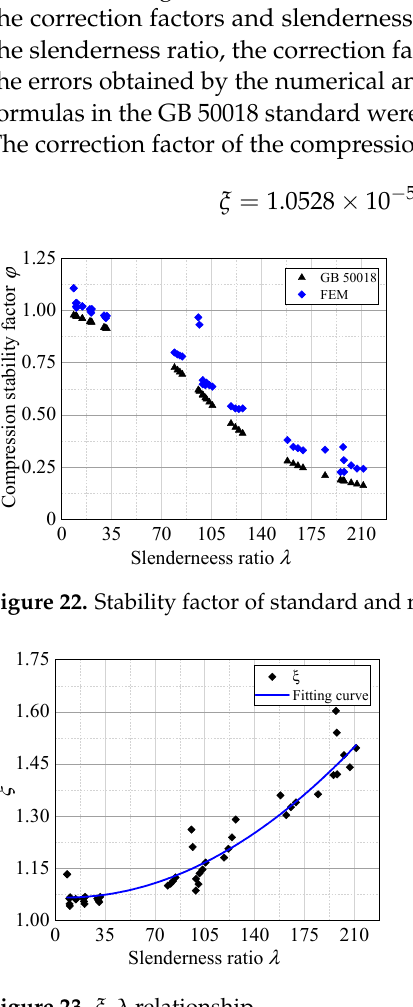
( d ) Figure 24. Comparisons of the ultimate compressive bearing capabilities ( a ) C90-40-15-1.5; ( b ) C120- 40-15-1.5; ( c ) C140-40-15-1.5; ( d ) C160-40-15-1.5. 4.3.2. Combined Column with Openings For the combined columns with openings, according to the parametric analyses, the slenderness ratio and opening ratio both have significant effects on the ultimate